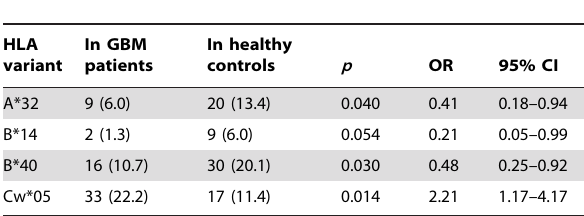
Table 3. Univariate analyses of HLA variants showing clear trend for association with occurrence of glioblastoma multiforme (GBM) in the Upper Midwest Health